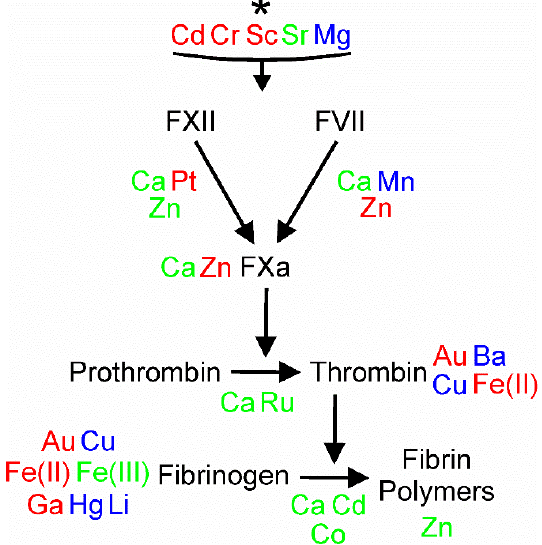
Figure 3. Effects of metals on coagulation. Metals depicted in green enhance coagulation, those displayed in red decrease clotting, and elements that are blue have conflicting effects on coagulation that may be concentration-dependent or dependent on the species source of the plasma or blood.